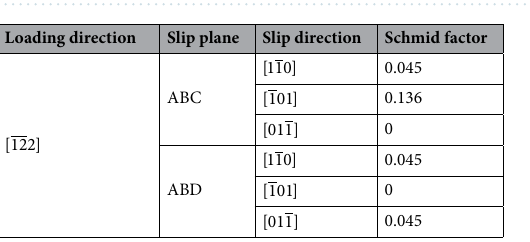
Figure 1. Schematics of in-situ TEM deformation (tensile) experiement. ( a ) Conceptual diagram of the tensile test geometry indicating possible displacements in the geometry of dislocations between projection images and the real space. ( b ) A representive TEM image showing the observed area and its crystallographic orientation.